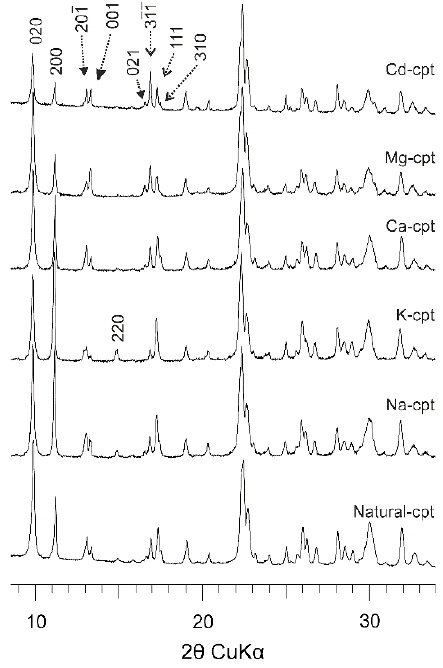
Figure 1. Powder XRD patterns of natural and ion-exchanged clinoptilolite.